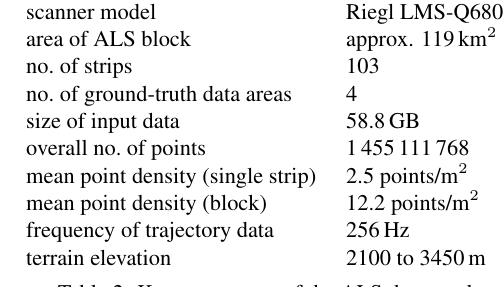
Table 2: Key parameters of the ALS data